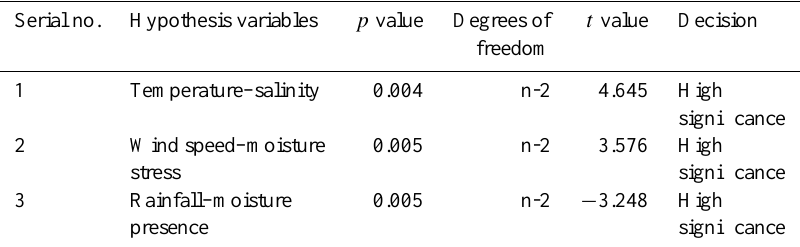
Table 1. Hypothesis combinations, computed t values with 1% level of significance, corresponding probability ( p score) and decision taken based on the tabulated values.